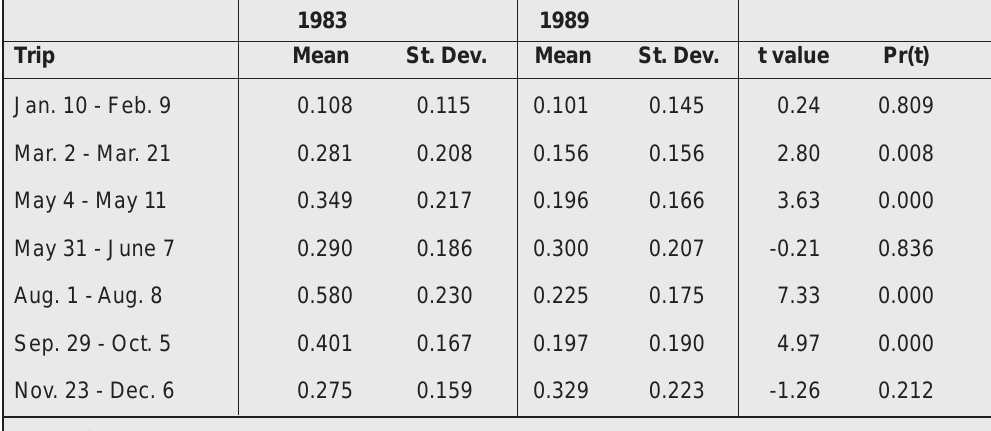
Table 2. Comparison of the mean proportion of mature worms in the stomachs of grey seals by trip between 1983 and